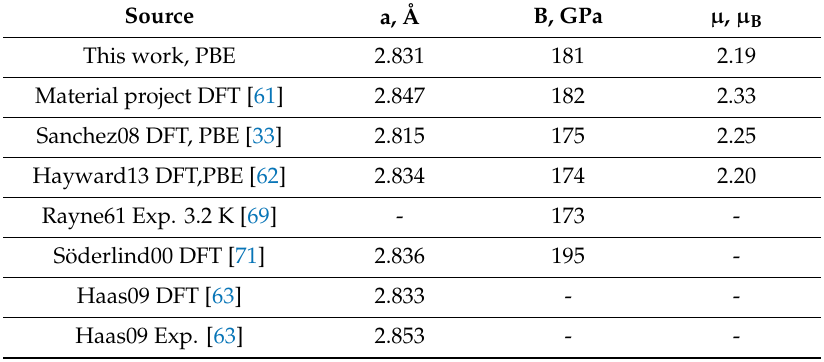
Table 1. Lattice parameter (a) and bulk modulus (B) and magnetic moment ( µ ) of bcc Fe. Source a, Å This work,